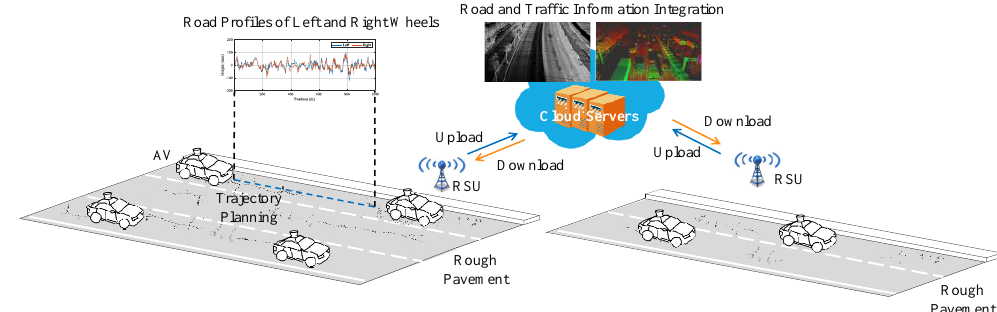
Figure 1. Intelligent speed control for AVs in the CVIS on rough pavements.